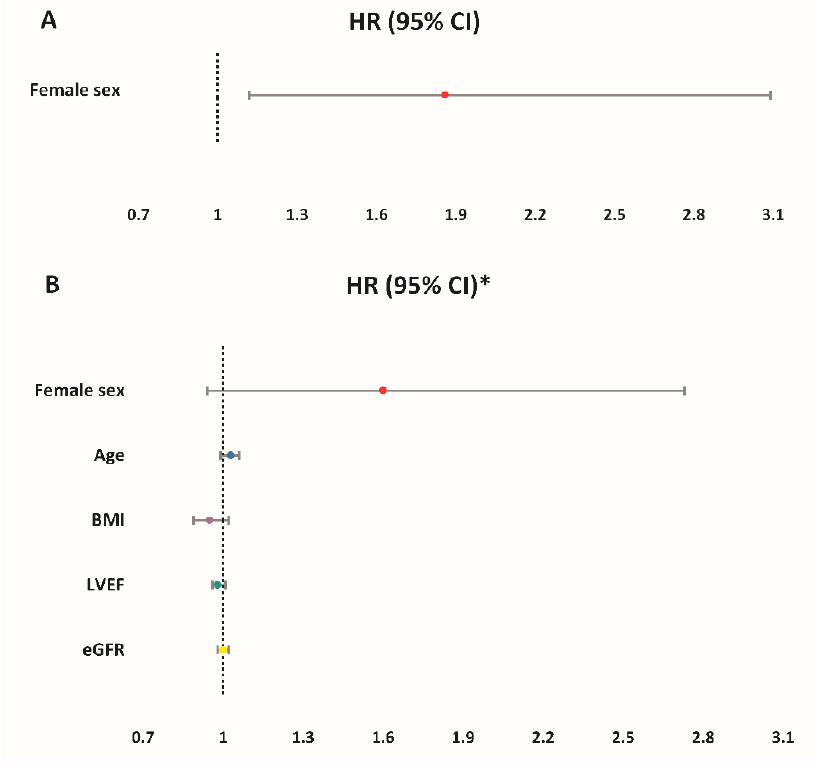
Figure 3. Event-free survival for MACCE according to sex. Legend: MACCE, major adverse cardi- ovascular and cerebrovascular events (composite of cardiac mortality, ischemic stroke, urgent cor- onary revascularization and nonfatal myocardial infarction).